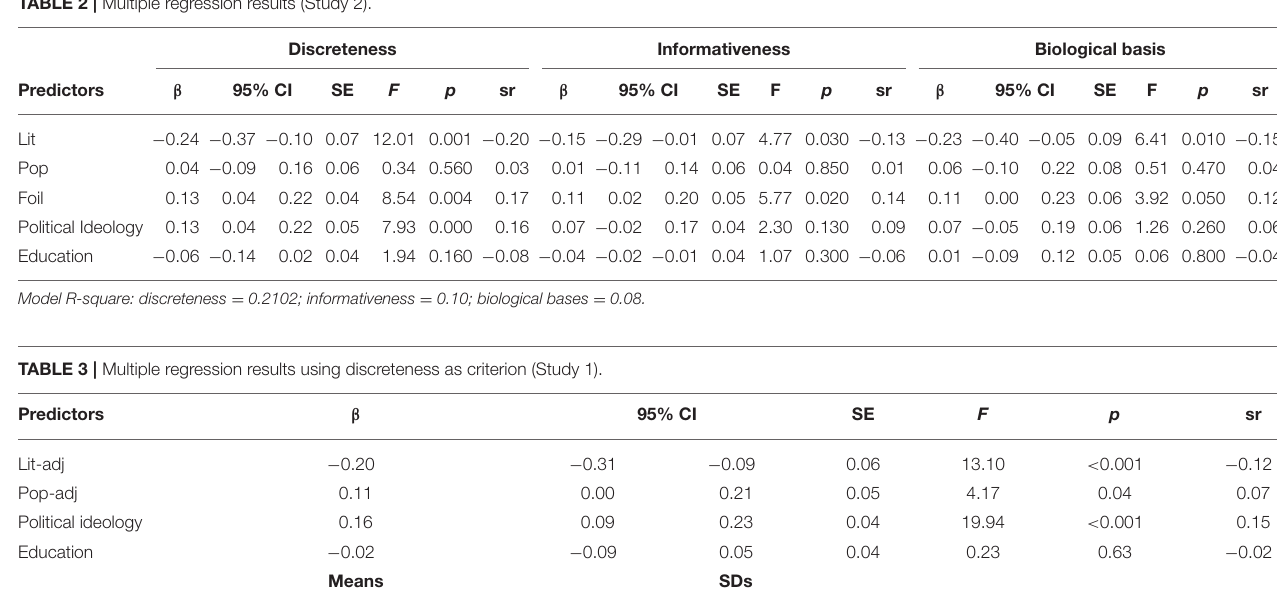
Discreteness Informativeness Biological basis